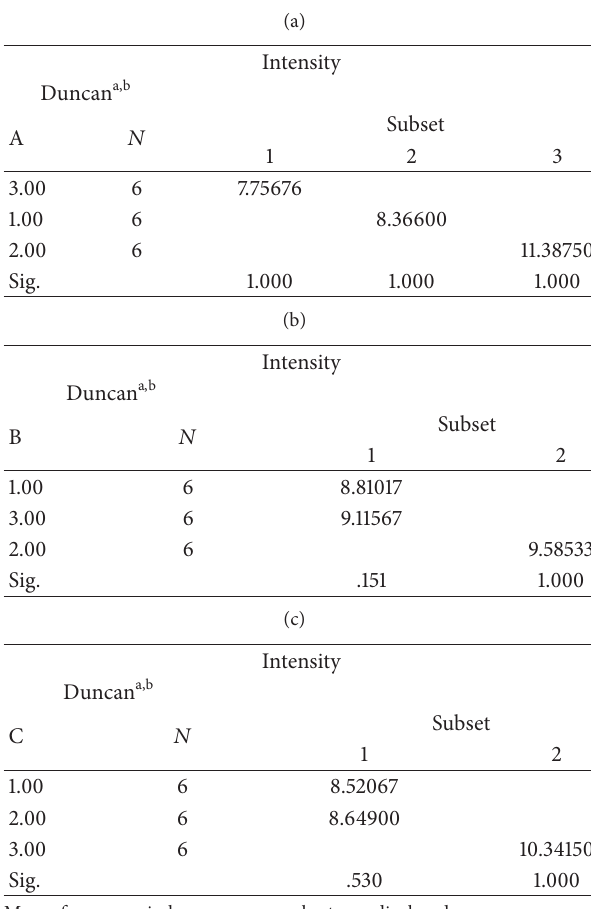
Table 3: Duncan’s multiple range test of (a) pressure, (b) tempera- ture, and (c)